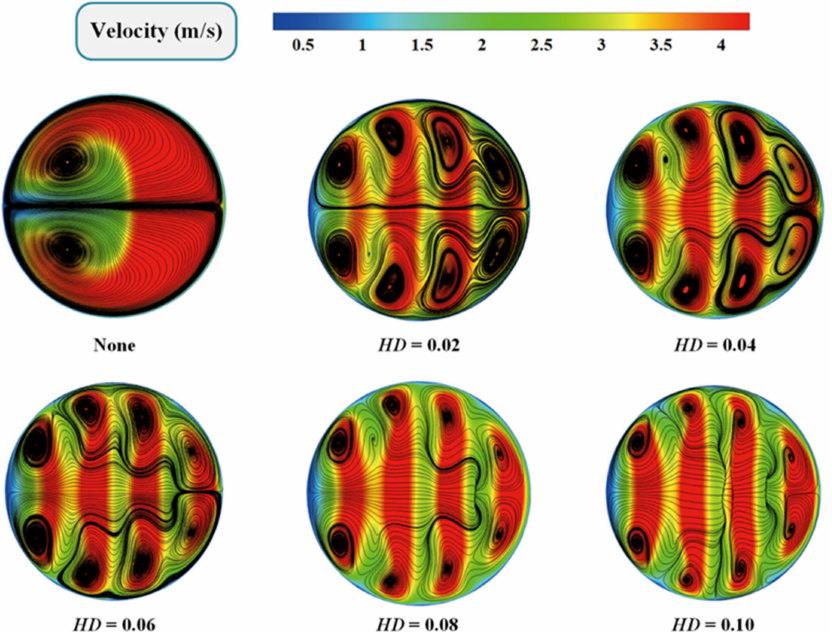
Figure 13. Velocity contour and streamline distribution of 0.67 D section downstream of 90 ◦ bend pipe with different thick-diameter ratio